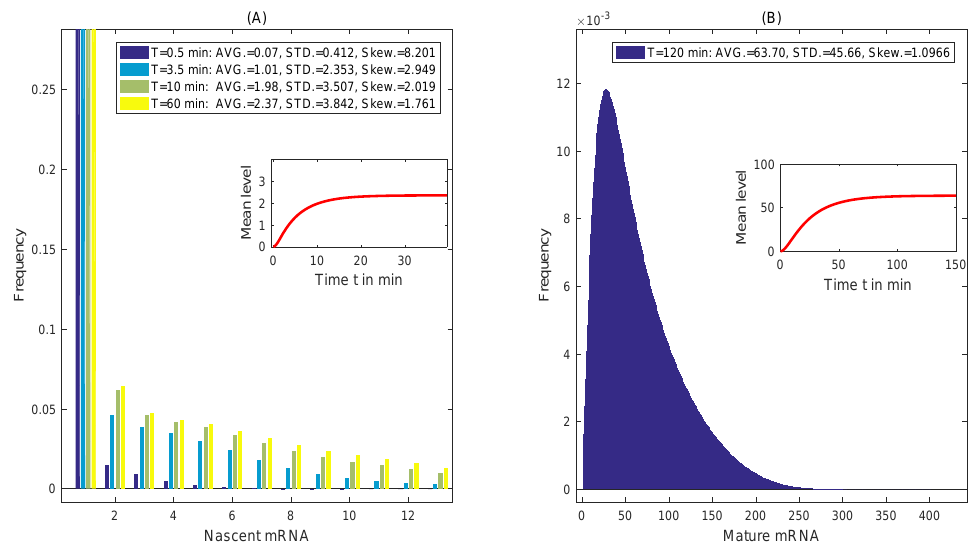
Figure 4. ( A ) The distribution of nascent mRNAs when ν 1 < ν 2 at different times; ( B ) the distribution of mature mRNAs when ν 1 < ν 2 at T = 120 min. Parameters are given in